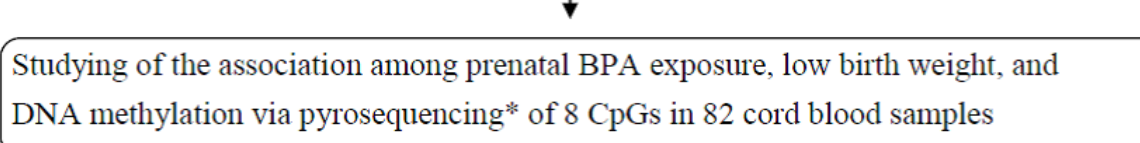
Figure 1. Flow chart in this study * bisulfite treatment and quantitative PCR (q-PCR).